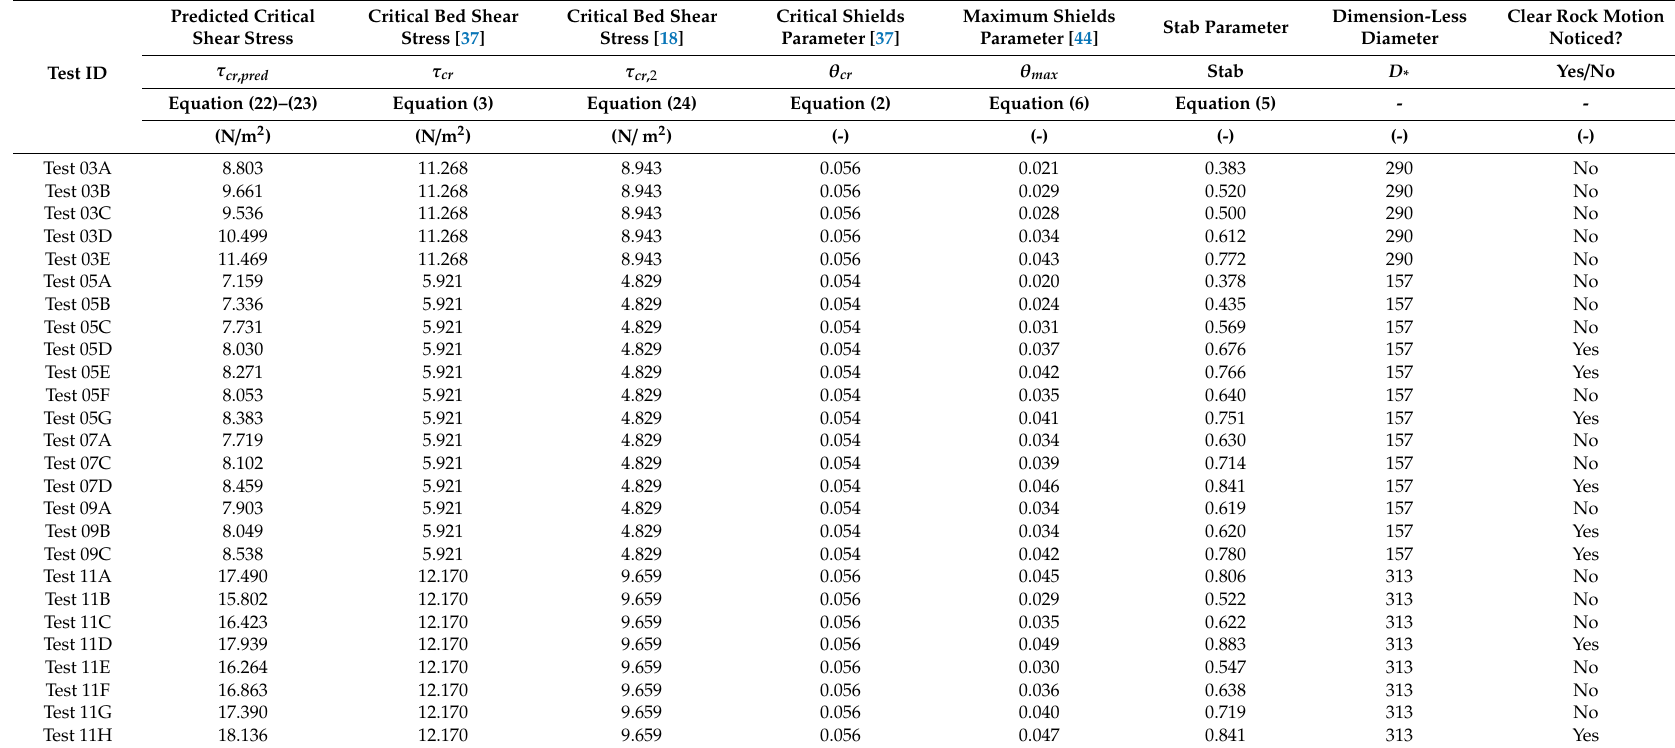
Table 4. Static stability analysis